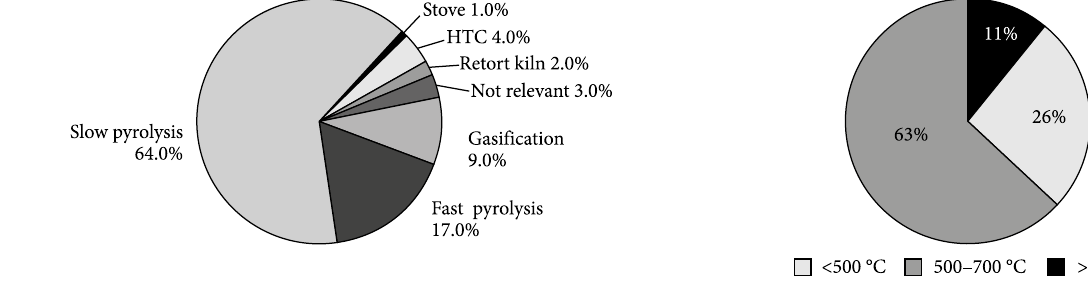
Fig. 3. Survey response of biochar producing technologies (n = 362), HTC – hydrothermal carbonization